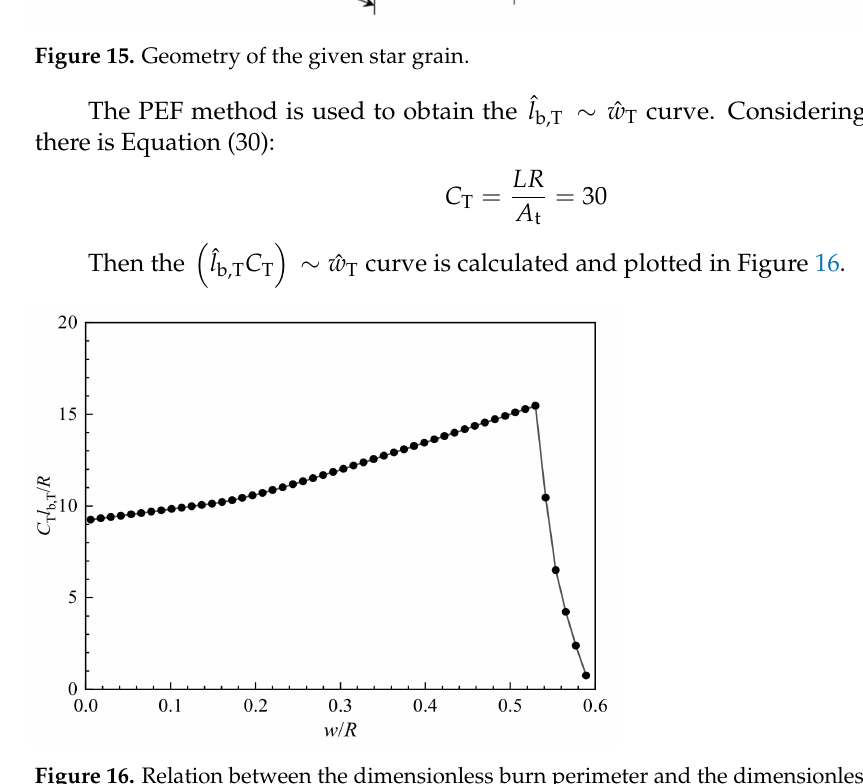
Figure 16. Relation between the dimensionless burn perimeter and the dimensionless web thickness of the given star